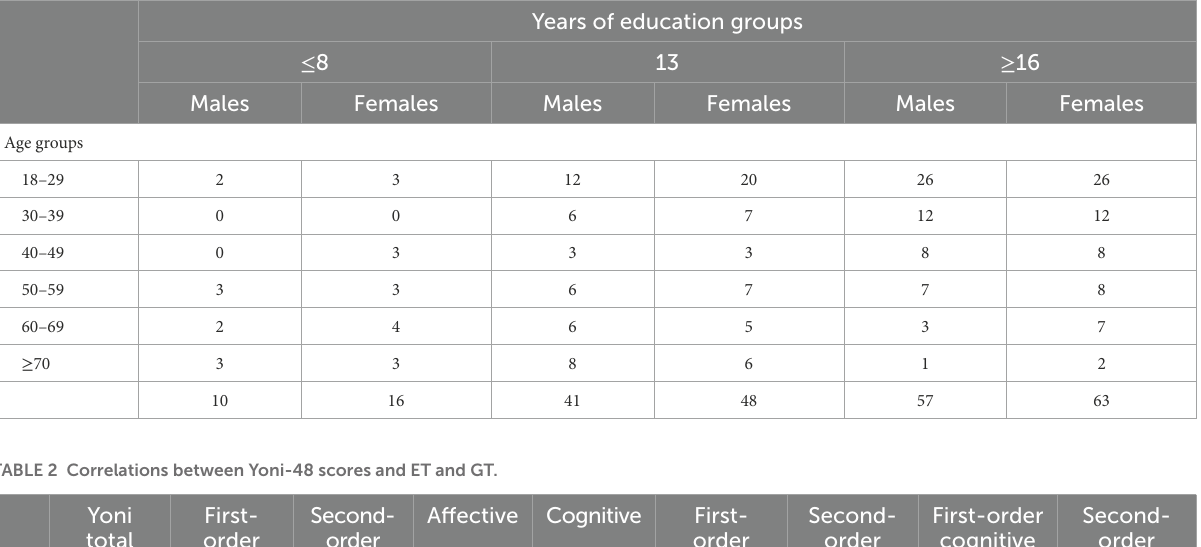
TABLE 1 Subjects’ numerousness in age, sex, and education groups.